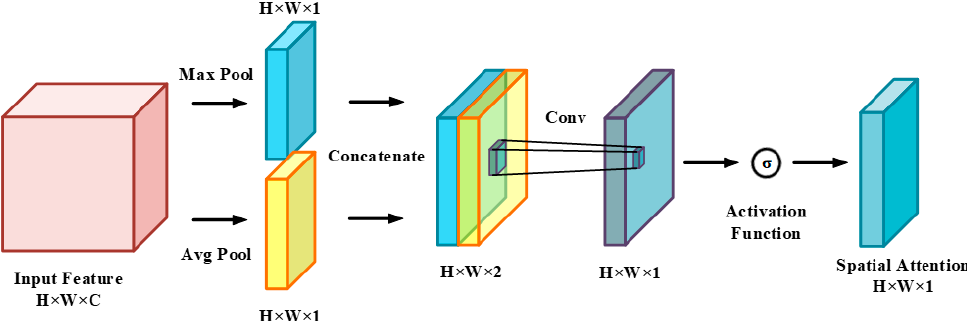
Figure 7. Spatial attention module.